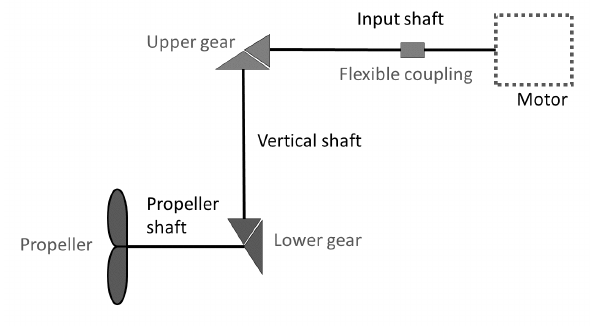
Figure 2: Simplified drawing of thruster driveline.